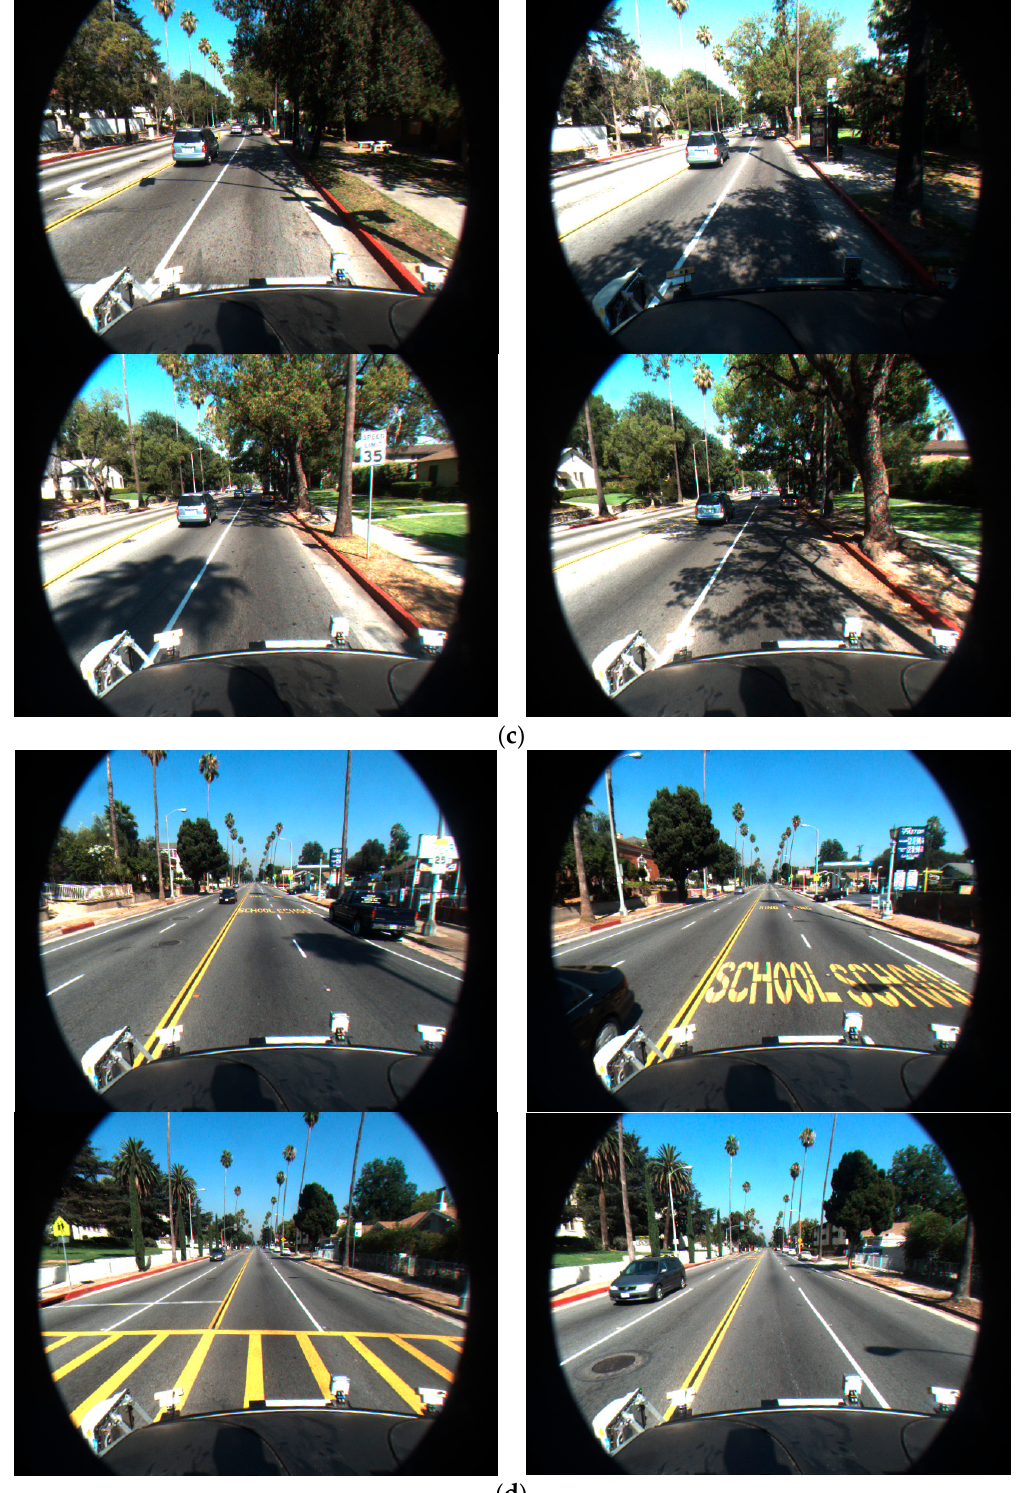
Figure 11. Examples of experimental datasets: ( a ) Cordova 1; ( b ) Cordova 2; ( c ) Washington 1; and ( d ) Washington 2. To measure the accuracy of lane detection, the ground-truth (starting and ending) positions of lane were manually marked in the images. Because our method can detect the left and right boundary positions of a road lane by discriminating the dashed and solid lanes, all the ground-truth positions were manually marked to measure the accuracy. Based on the inter-distance between two